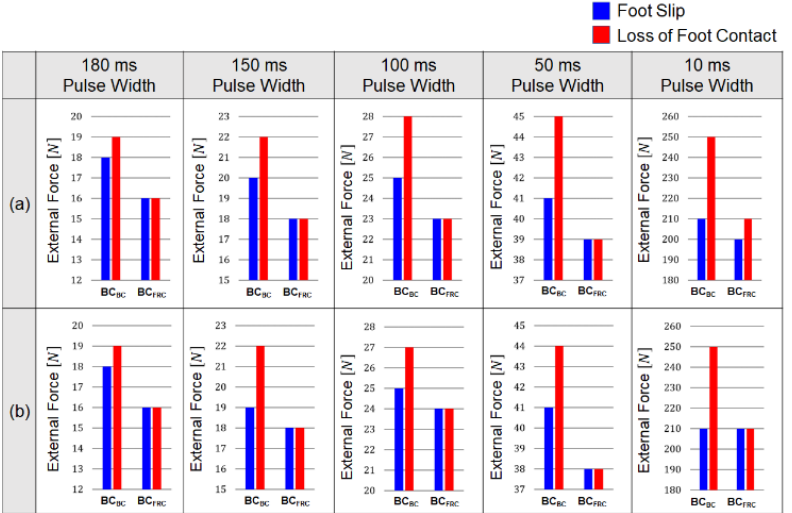
Figure 13. Amplitude of the external forces where foot position of the robot in the dynamic simulator changed in the lateral direction (foot slip) and the vertical direction (loss of foot contact): Results when a square-shaped external force with a pulse width of 180, 150, 100, 50, and 10 ms was applied with the inter pulse interval of ( a ) 3600 ms and ( b ) 400 ms.